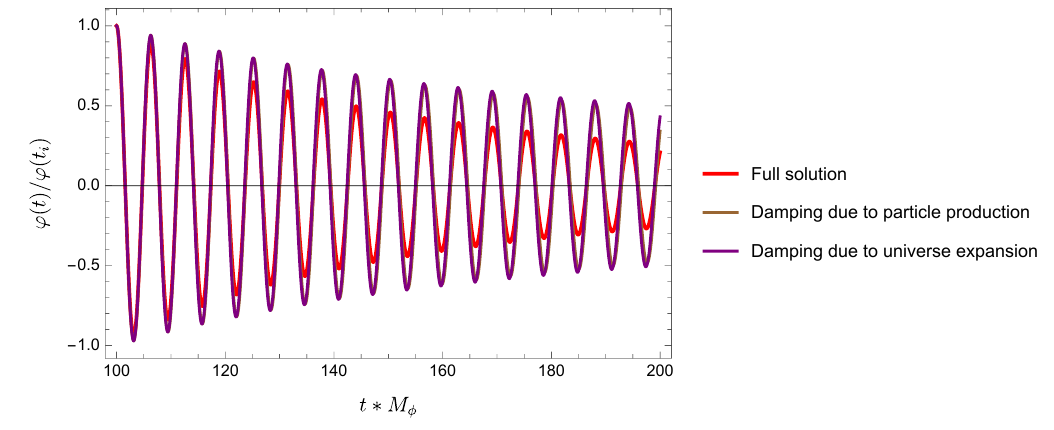
Figure 16 . Solutions of the condensate equation (2.24). Analytic approximation in a matter- dominated universe, i.e., eq. (A.7), is drawn in the red line with σ = − α = 0 . 01 /M φ , µ = 0 . 01 M φ , γ = 0 . 005 M φ , λ φ = 0 . 05 . Analytic approximation in a static universe with the same parameters, given by eqs. (3.29) and (3.30), is drawn in the brown line. Analytic approximate solution